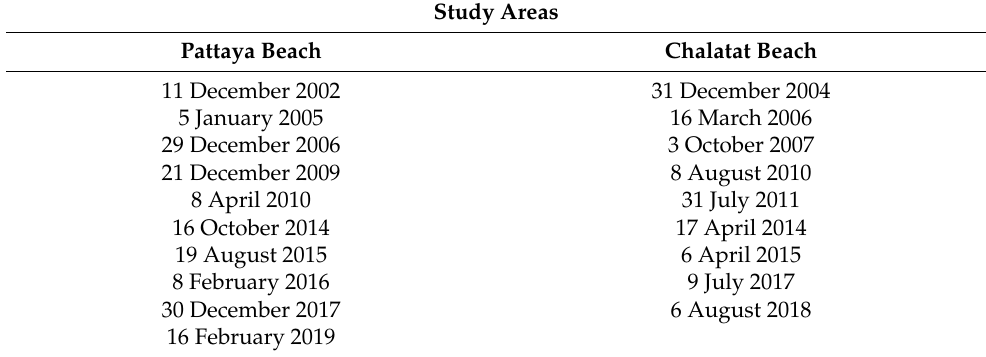
Table 1. Time series of satellite images.